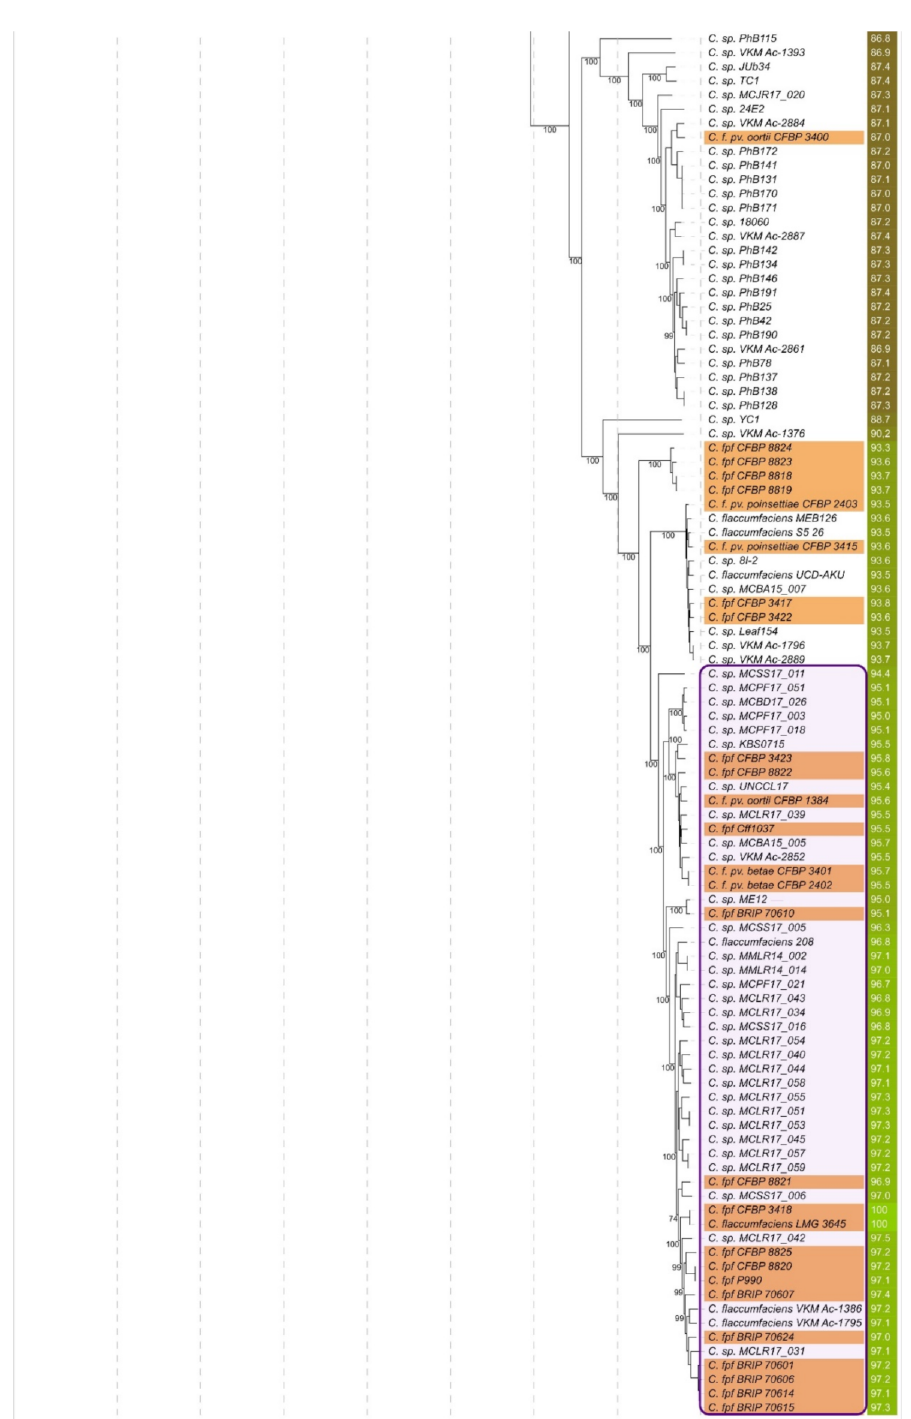
Figure 4. Best-scoring phylogenetic trees obtained with RAxML using 190 Curtobacterium genomes. The abbreviations are as follows: C. — Curtobacterium , C. f. — Curtobacterium flaccumfaciens , and C. fpf — flaccumfaciens pv . flaccumfaciens . The C. fpf strains with confirmed pathogenicity are coloured yellow-orange. The group of 53 strains outlined with violet constitutes a possible reclassified species of C. flaccumfaciens , based on the ANI and phylogeny results. ANI values compared to the C. fpf CFBP 3418-type strain are shown to the right of the organism’s name and coloured according to a heat map scale. Bootstrap support values are shown near the branches of the rectangular tree as a percentage of 1000 replicates. The scale bar shows 0.1 estimated substitutions per site, and the tree was rooted to Curtobacterium ammoniigenes NBRC